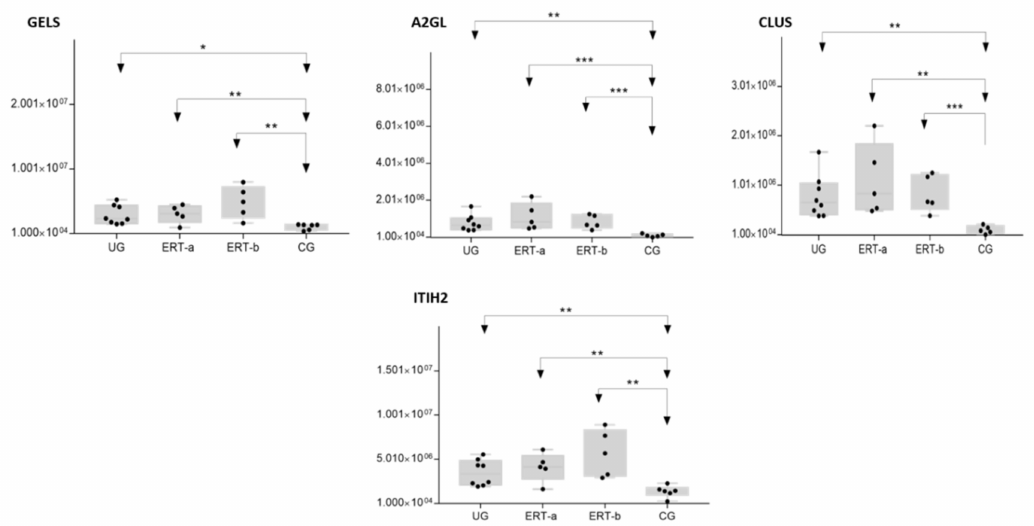
Figure 11. Box plot depictingthe4 plasma proteins (A2GL, CLUS, GELS, ITIH2) with the highest expression levels in the UG and ERT-a and ERT-b groups relative to the control group (CG). Each data point represents the median value obtained in an individual sample. The line inside the box represents the median of all values obtained. The upper and lower limits of the box represent the first and third quartiles. Whiskers represent the minimum and maximum values within 1.5 times the interquartile range. Any data points not included between the whiskers are considered outliers. * p < 0.05; ** p < 0.01; *** p < 0.001.